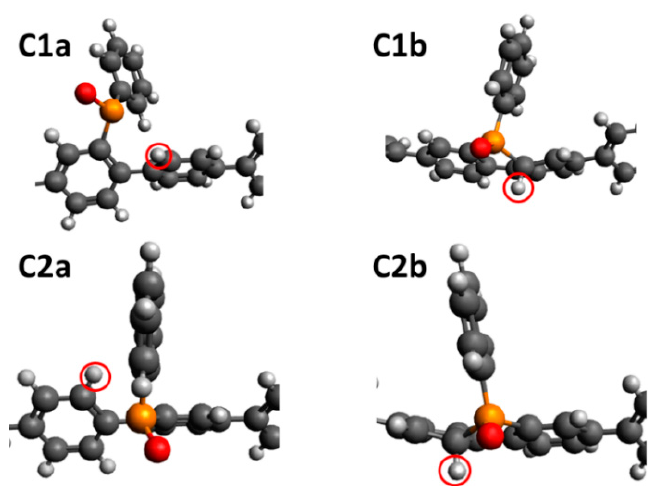
Figure 6. Possible configurations of proton binding onto C1 and C2.